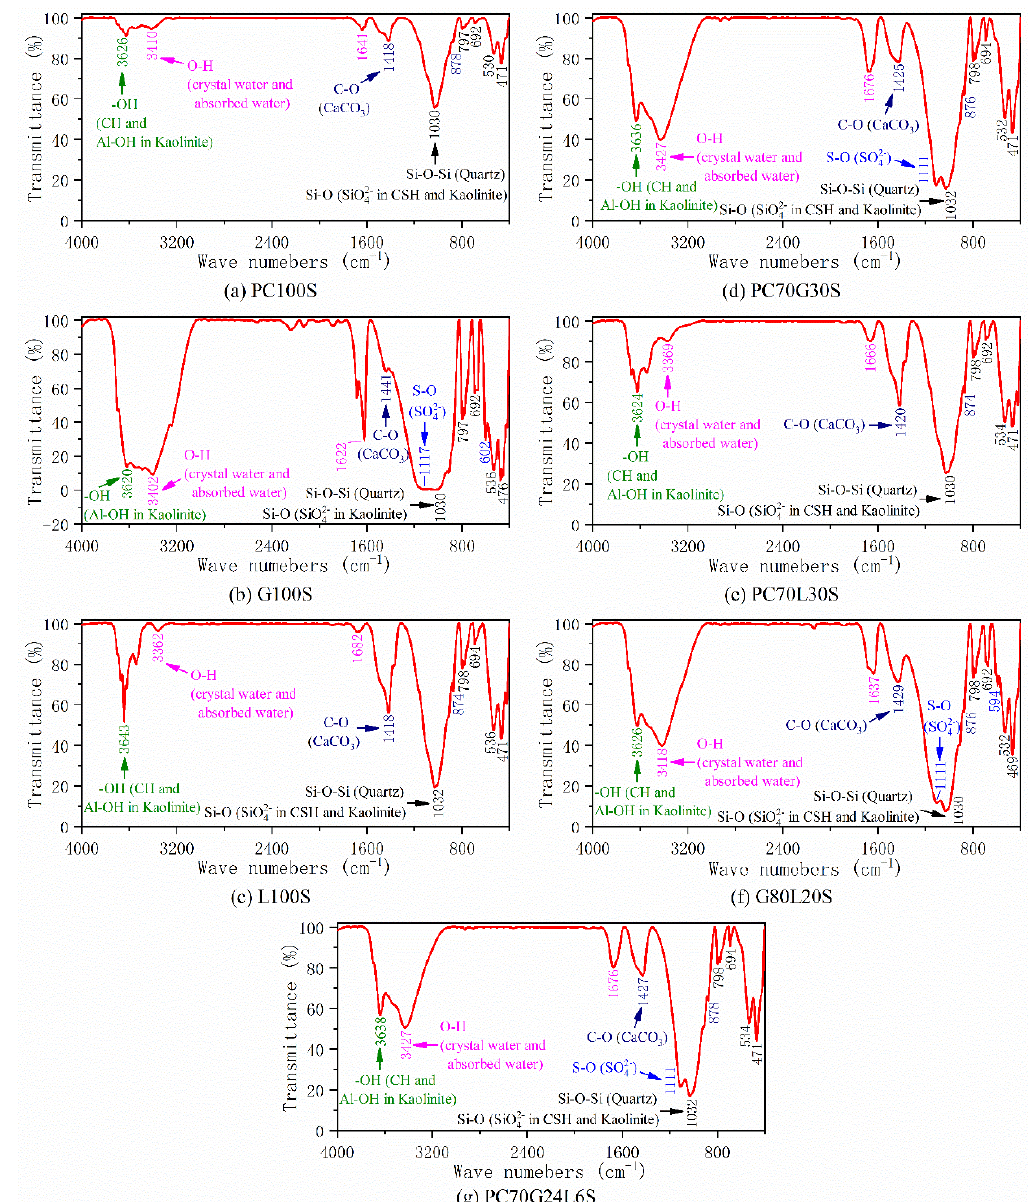
Figure 6. Fourier transform infrared spectroscopy (FTIR) spectrograms of the stabilized soil samples.